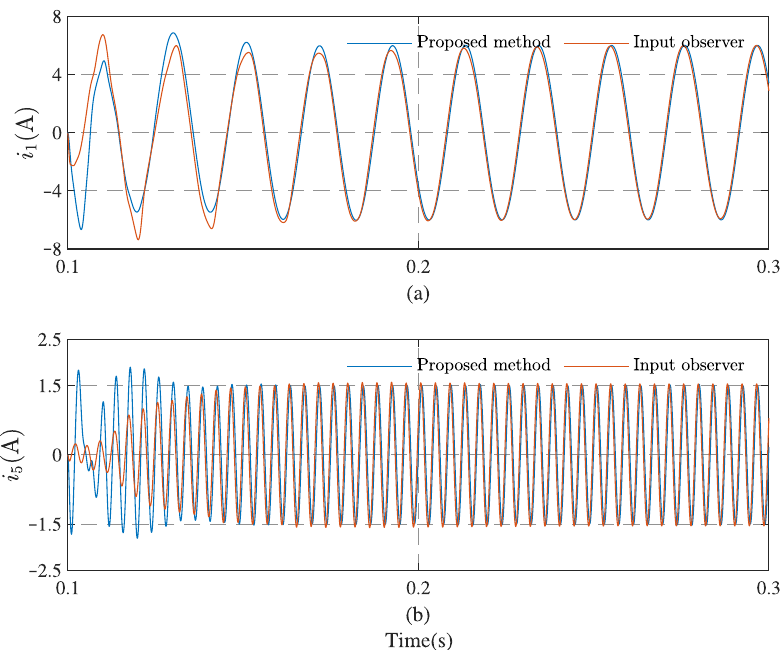
Figure 19. ( a ) Fundamental wave. ( b ) Fifth